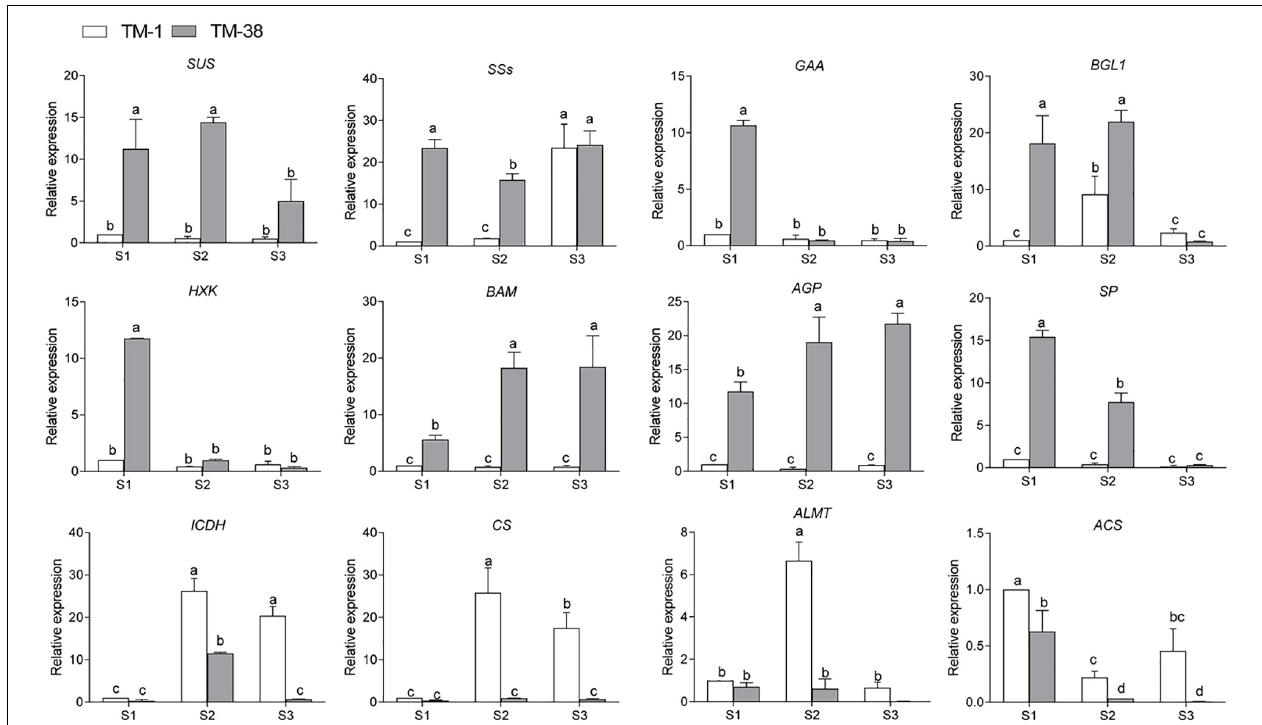
FIGURE 8 | qRT-PCR assay, the mean was calculated from three biological replicates, each with three technical replicates ( n = 9). These replicates were then normalized relative to the expression of Actin .